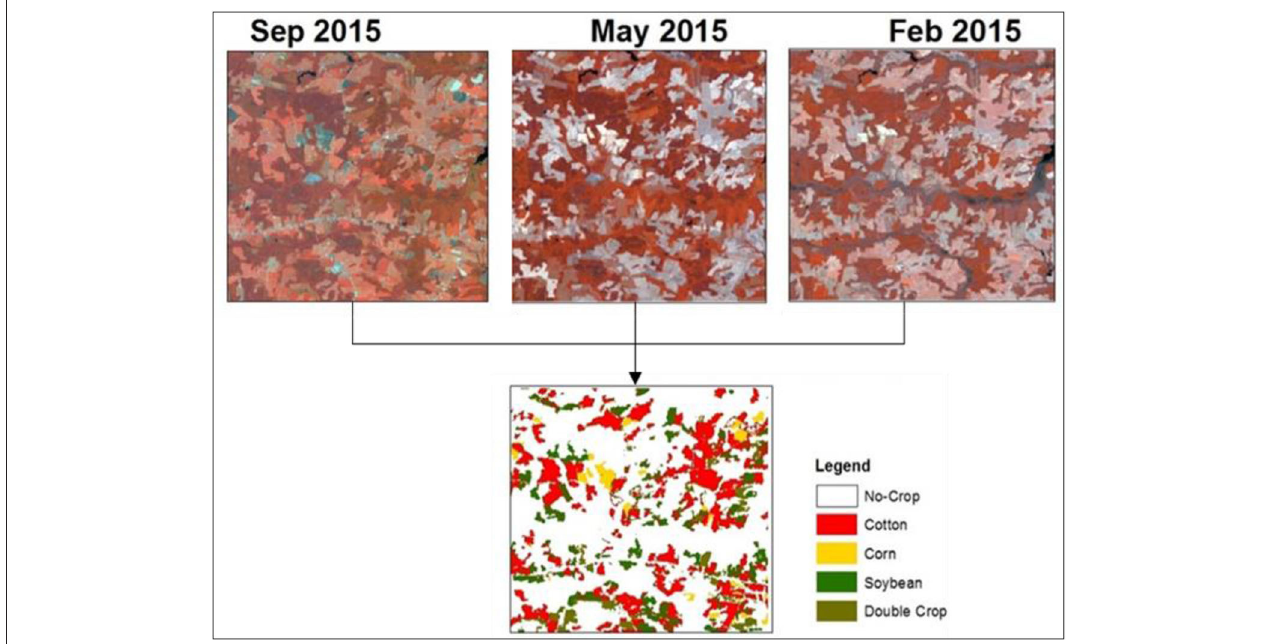
FIGURE 9 | The crop type map developed from the multi dates of World View-2 imagery showing the unique spectral characteristics for the different crop types of the medium field size TR